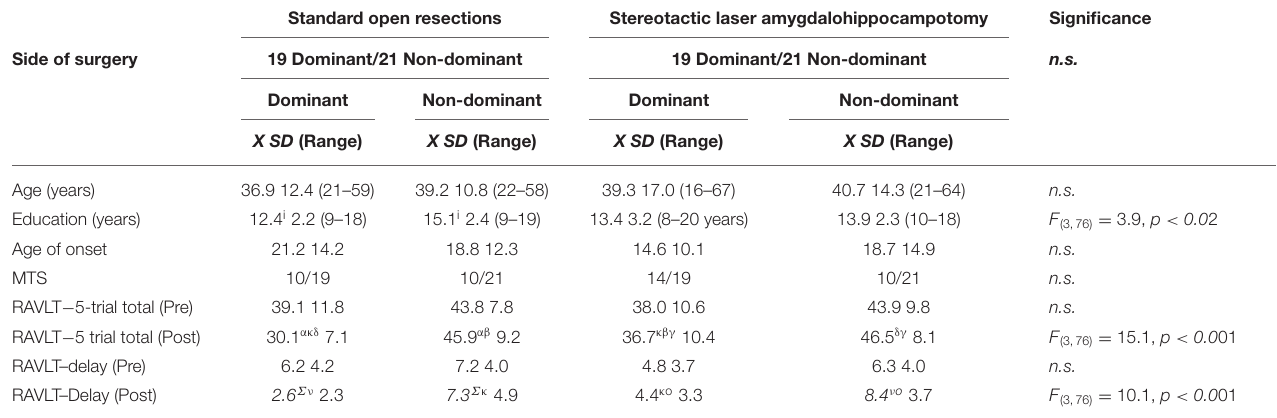
TABLE 1 | Demographic, disease-related variables, surgical characteristics, and test performances by surgical group.